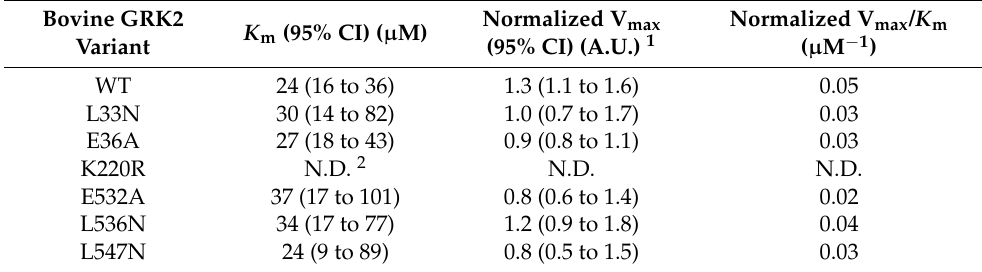
Figure 4. Michaelis–Menten analysis of the GRK2 variants varying ATP concentration ([ATP]). Bovine GRK2 variants with a C-terminal H 6 tag purified from HEK293F cells were analyzed by Michaelis–Menten kinetics. ( A ) Tubulin and ( B ) rod outer segments (ROS) phosphorylation by the GRK2 mutants, as detected by SDS-PAGE (left, corresponding to the results from a single representative experiment). Bands correspond to the phosphorylated product at variable [ATP] (0–75 µ M). Band intensities were fitted to the Michaelis–Menten model using GraphPad Prism (right). Plots contain data from three experiments, and error bars represent the standard deviation (SD). Table 2. Steady-state parameters for rhodopsin phosphorylation when [ATP] is